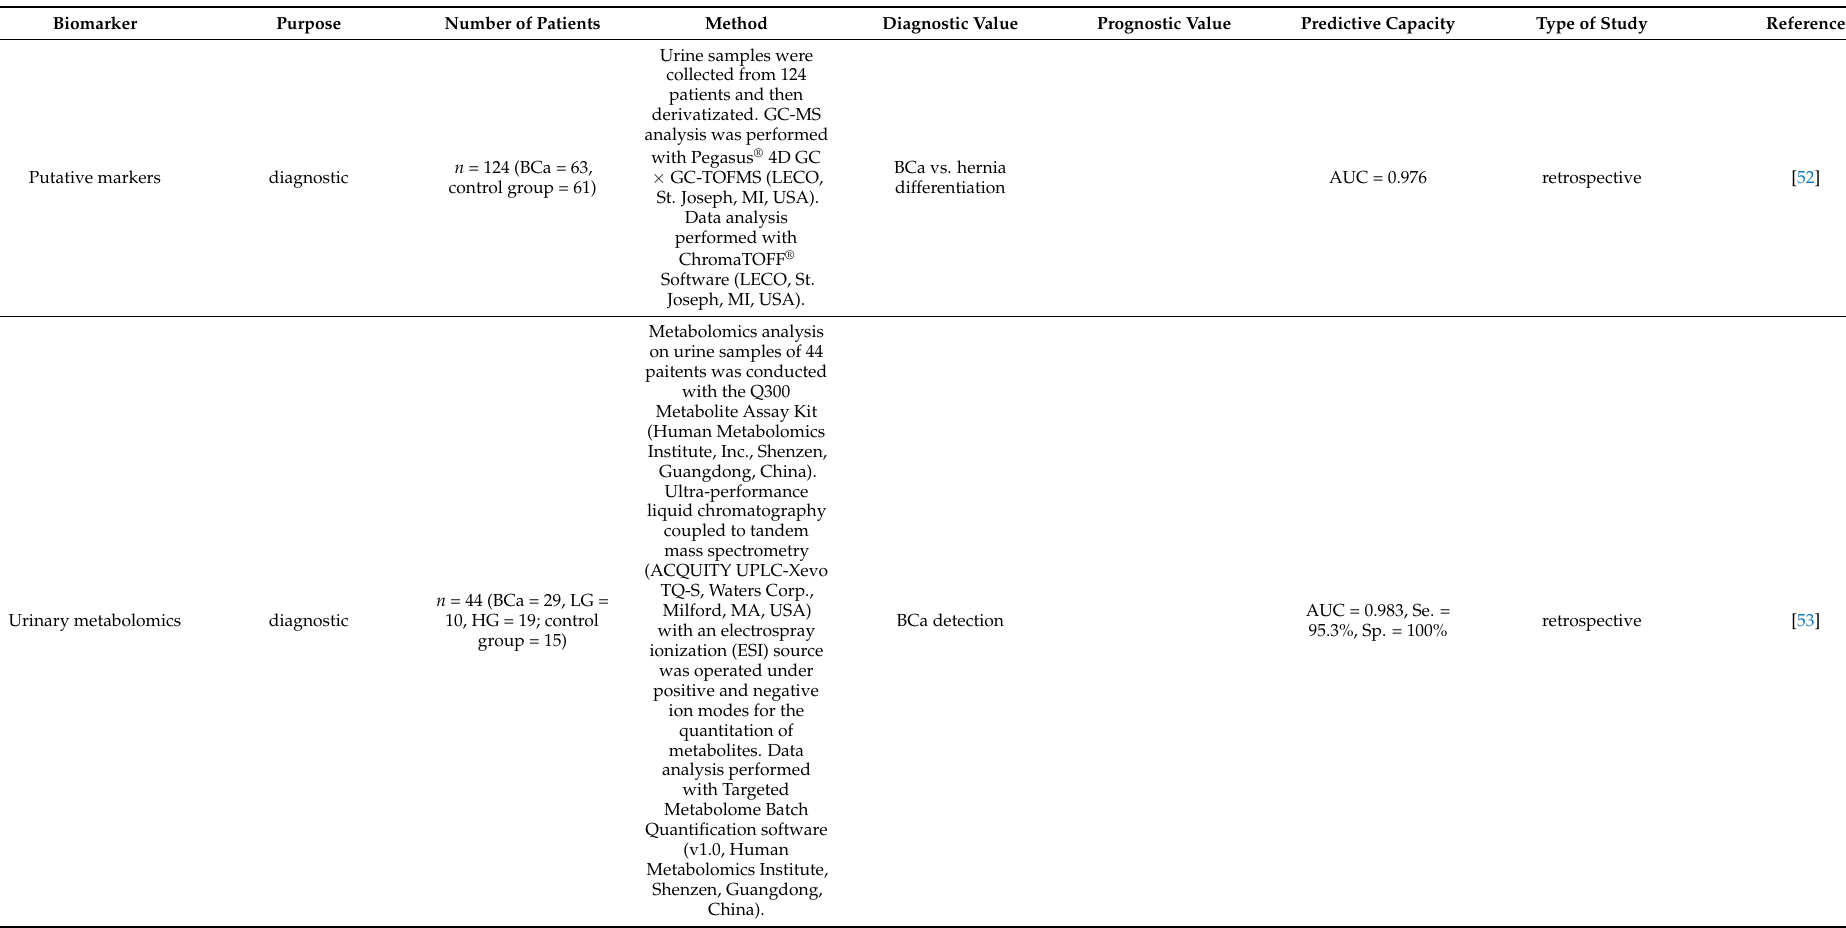
Table 6. Table presenting data for metabolites